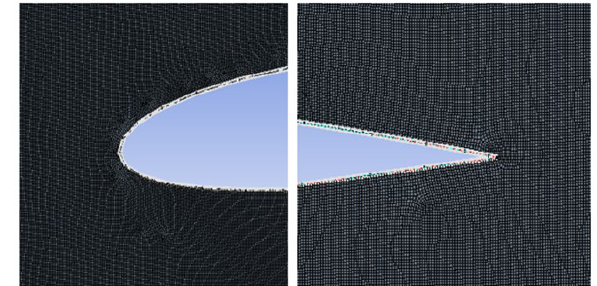
Figure 5. Meshed geometry near airfoil edges (Zoom